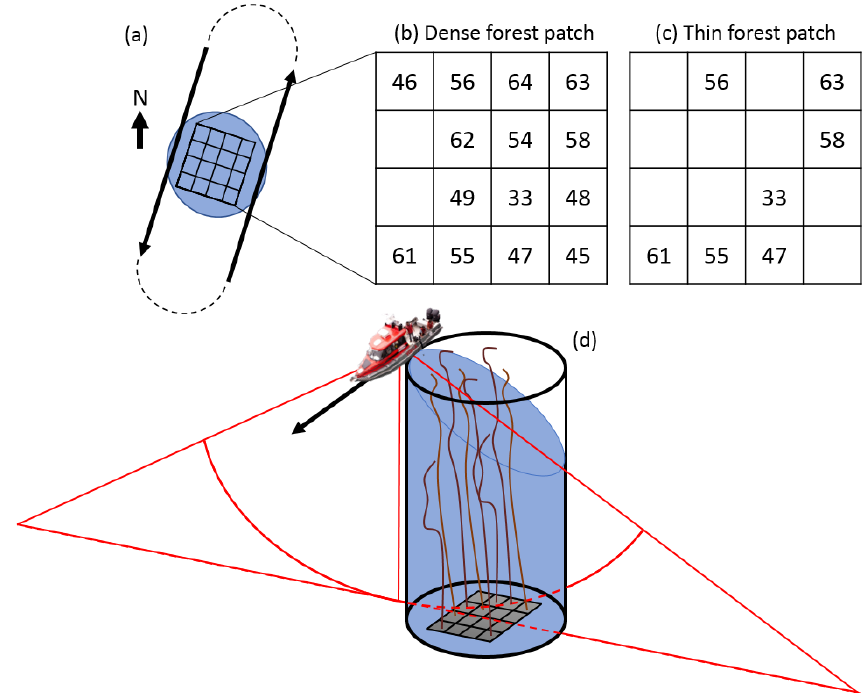
Figure 2. ( a ) Illustration of the data acquisition procedure, consisting of running the vessel on predefined tracks (arrows) on either side of the patch (4 × 4 m quadrat), keeping it always on portside. The blue circle represents the base of the “target volume”. ( b ) Location of each plant in the 4 × 4 m quadrat for the dense forest patch. Numbers in each cell correspond to the bag tag labels indicated in Table 1. ( c ) Idem for the thin forest patch. ( d ) 3D illustration of how the volume of water-column actually insonified in any given raw data file (in blue) misses the top part of the target volume (full cylinder) due to the limited angular aperture of the swath.